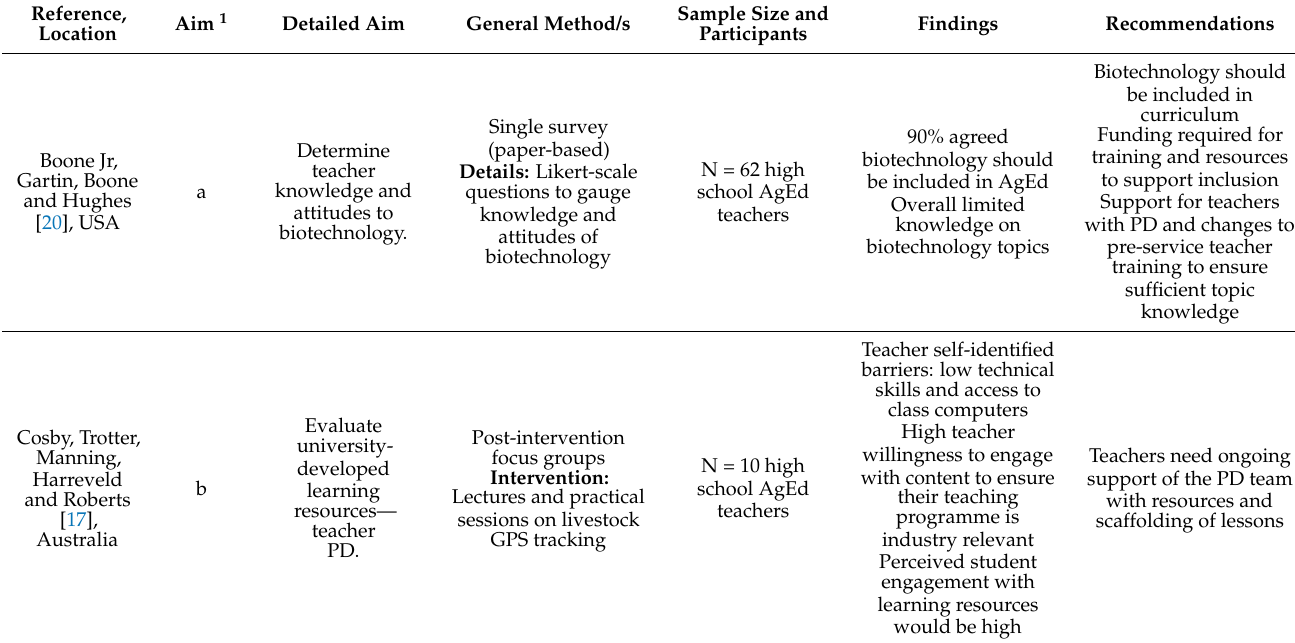
Table A1. Analytic matrix of